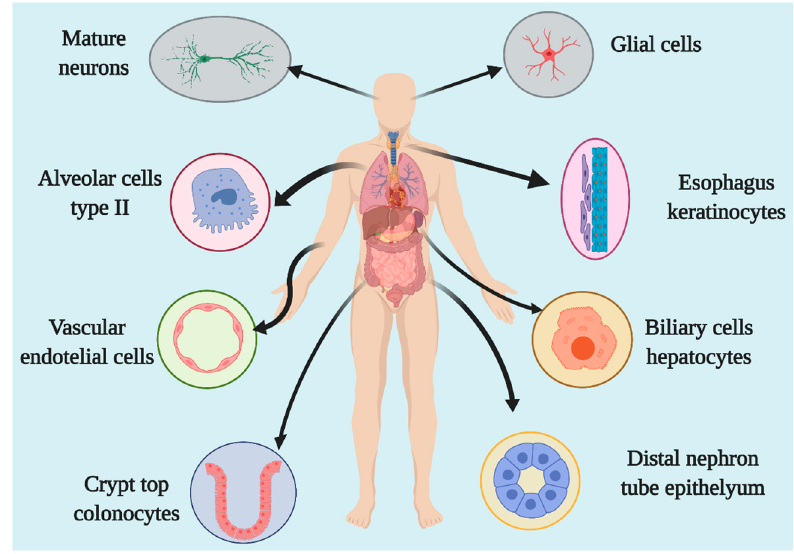
Figure 2. The organs and cells expressing ACE2.